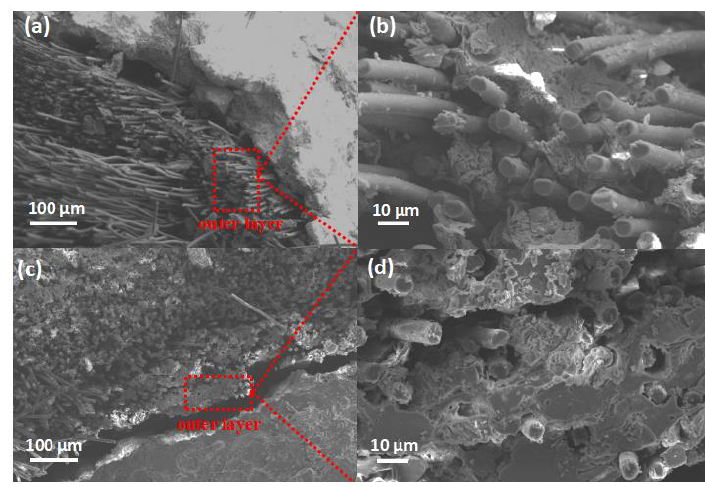
Figure 5. Scanning electron microscope (SEM) images of the specimen cross sections fired at ( a, b ) 1200 ℃ and ( c, d ) 1300 ℃.